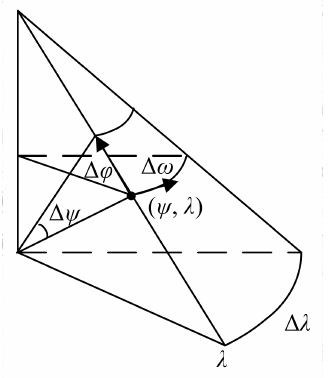
Figure 2. Schematic diagram of the relationship between ( ψ , λ ) and ( ∆ ϕ , ∆ ω